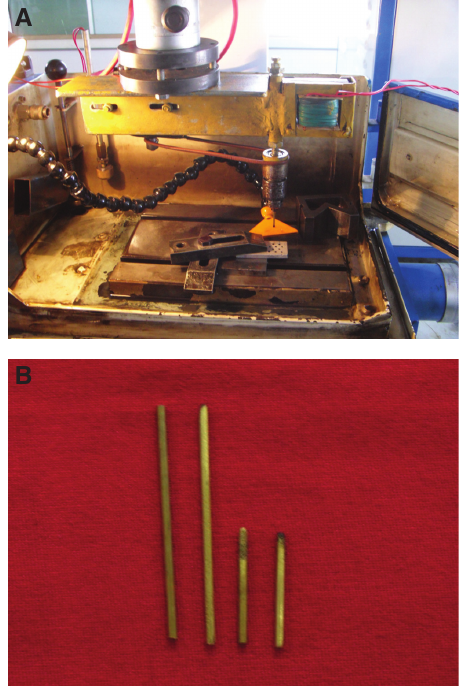
Figure 2 (A) Vibration setup in the experiment with tool and work- piece. (B) Brass